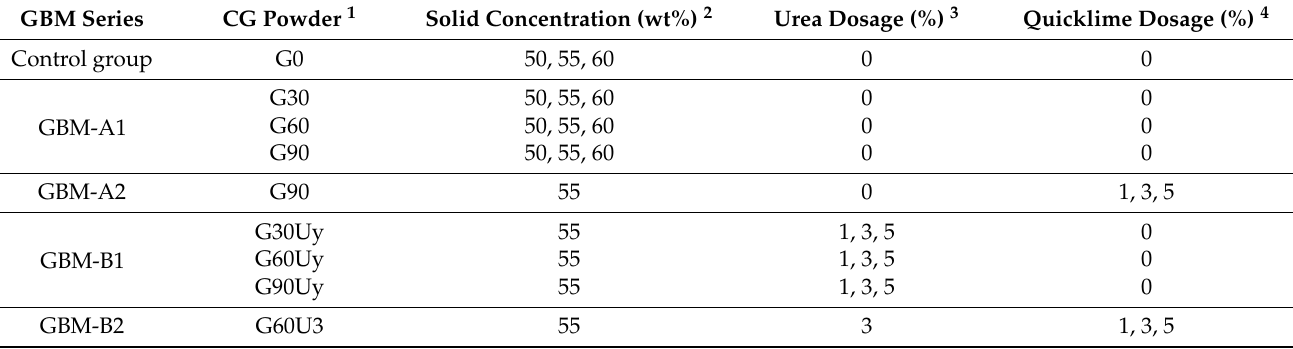
Table 1. Mix ratio of raw materials to prepare GBM